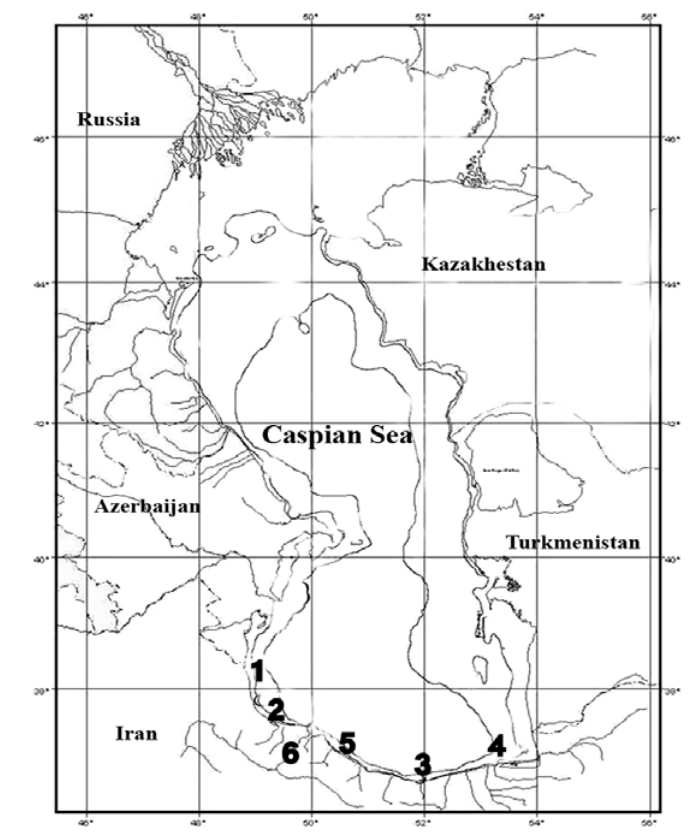
F IGURE 1. Map showing the locations of the Persian sturgeon sampling sites in the Caspian Sea. Sampling localities: 1, Astara-Anzali (Zone1); 2, Kiashahr-Chaboksar (Zone 2); 3, Noshahr-Sari (Zone 3); 4, Miankaleh- Bandare Torkaman (Zone 4); 5, Chaboksar-Noshahr (Zone 5); 6, Sefidroud River; from south Caspian Sea along the Iranian coast. T ABLE 2. PCR condition and reaction, locus, product sizes and repeat motifs on Persian sturgeon. Product Locus